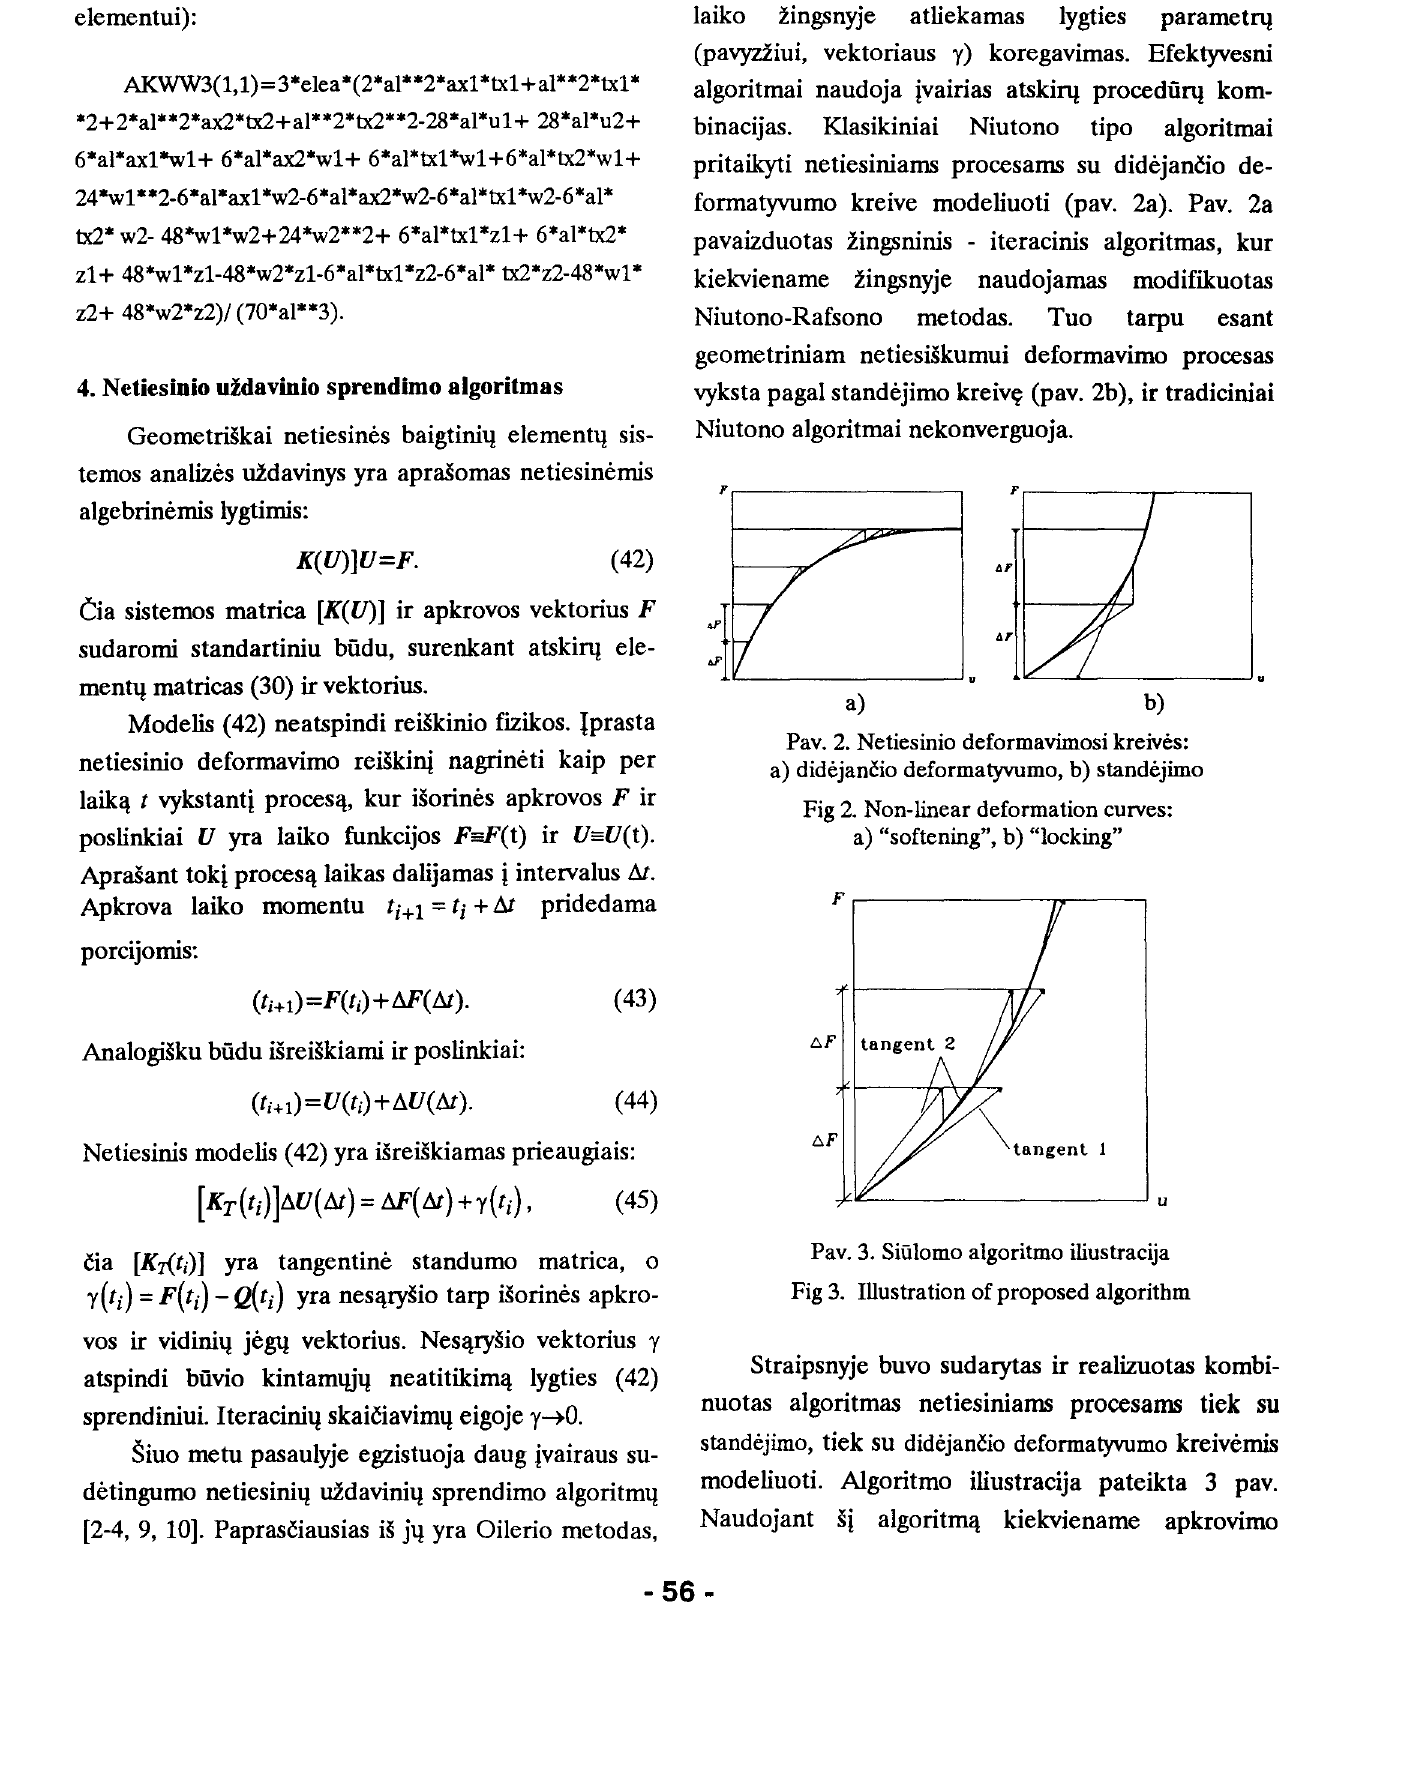
Fig 3. Illustration of proposed